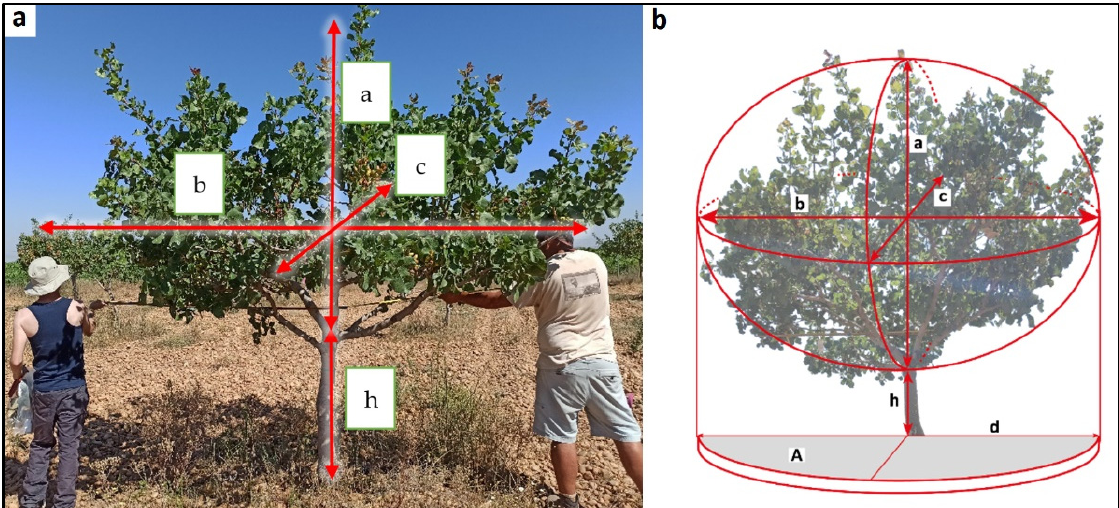
Figure 4. ( a ) Ground-truth measurements. The canopy’s height, length and width are a, b and c, respectively. h is the distance from the canopy to the ground. ( b ) Pistachio crown shape, considered as an ellipsoid.